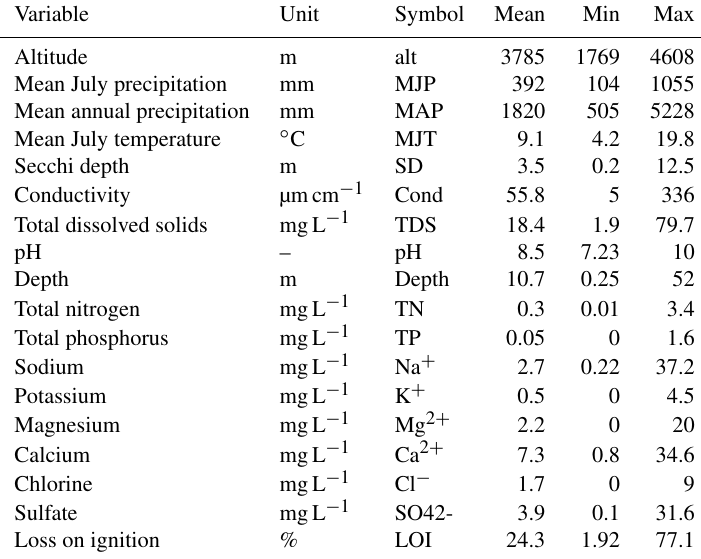
Table 1. List of all the 18 environmental and climate variables measured from 100 south-western Chinese lakes, with mean, minimum and maximum